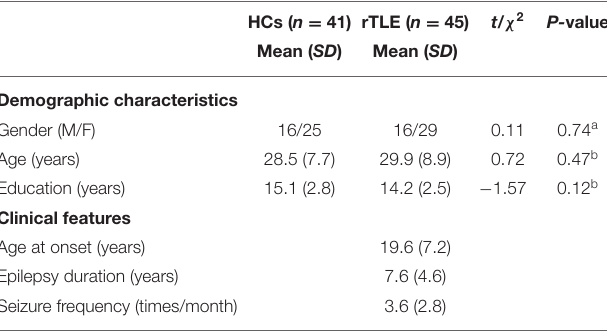
TABLE 1 | Demographic and clinical data for right temporal lobe epilepsy (rTLE) and healthy controls